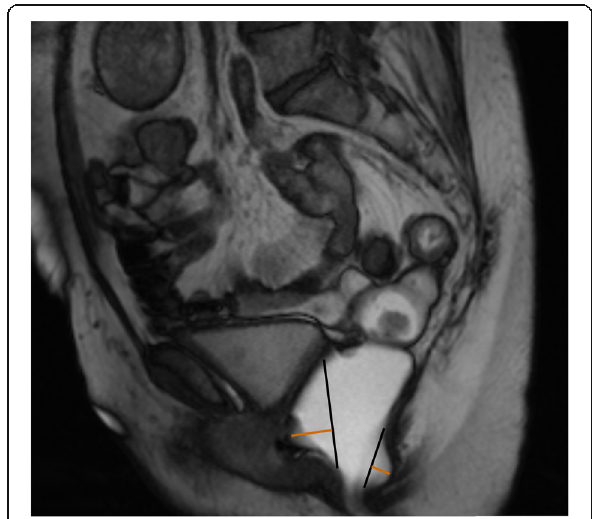
Fig. 12 Small rectoceles. Sagittal midline TrueFISP image during evacuation, showing both anterior and posterior small rectoceles. Black lines : normal expected contours of the anorectal wall; orange lines : extent of the rectoceles: 13 mm anterior and 9 mm